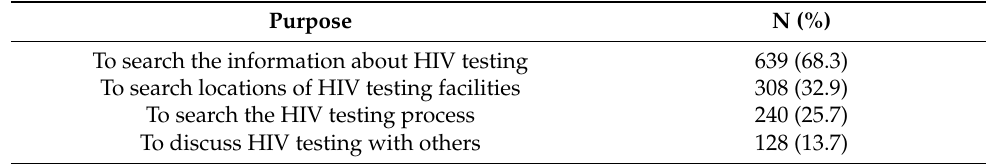
Table 2. The purpose of searching through the Internet.